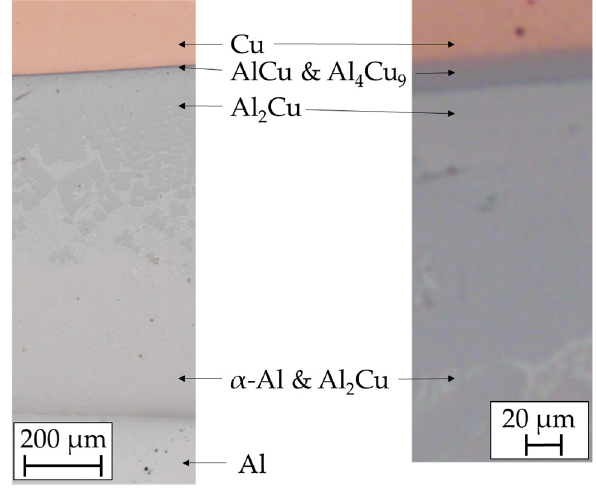
Figure 3. Example of a microscopic image of a polished composite casting sample. The corresponding EDX line scans shown in Figure 4 demonstrate the chemical com- position of the di ff erent phases. Based on their stoichiometric compositions, the phases close to the copper insert can be assumed to be of the Al 4 Cu 9 and AlCu type.